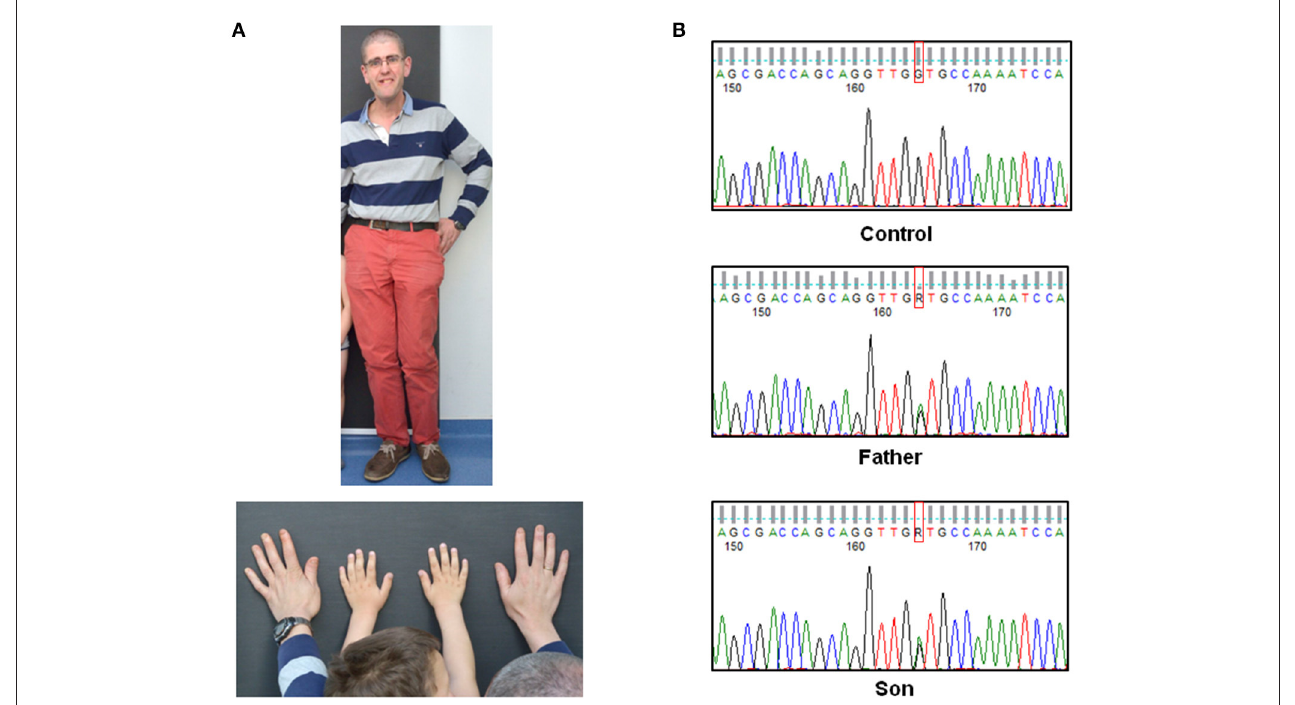
FIGURE 1 | Physical characteristics of the patients and confirmation of the NSD1 gene variant. (A) Photographs of the two patients showing large hands in both of them and macrocephaly, facial asymmetry and tall height in the father. (B) Electropherogram of the genomic sequence obtained by Sanger sequencing confirming the NSD1 variant identified by targeted exome sequencing in the patients. The control did not present the